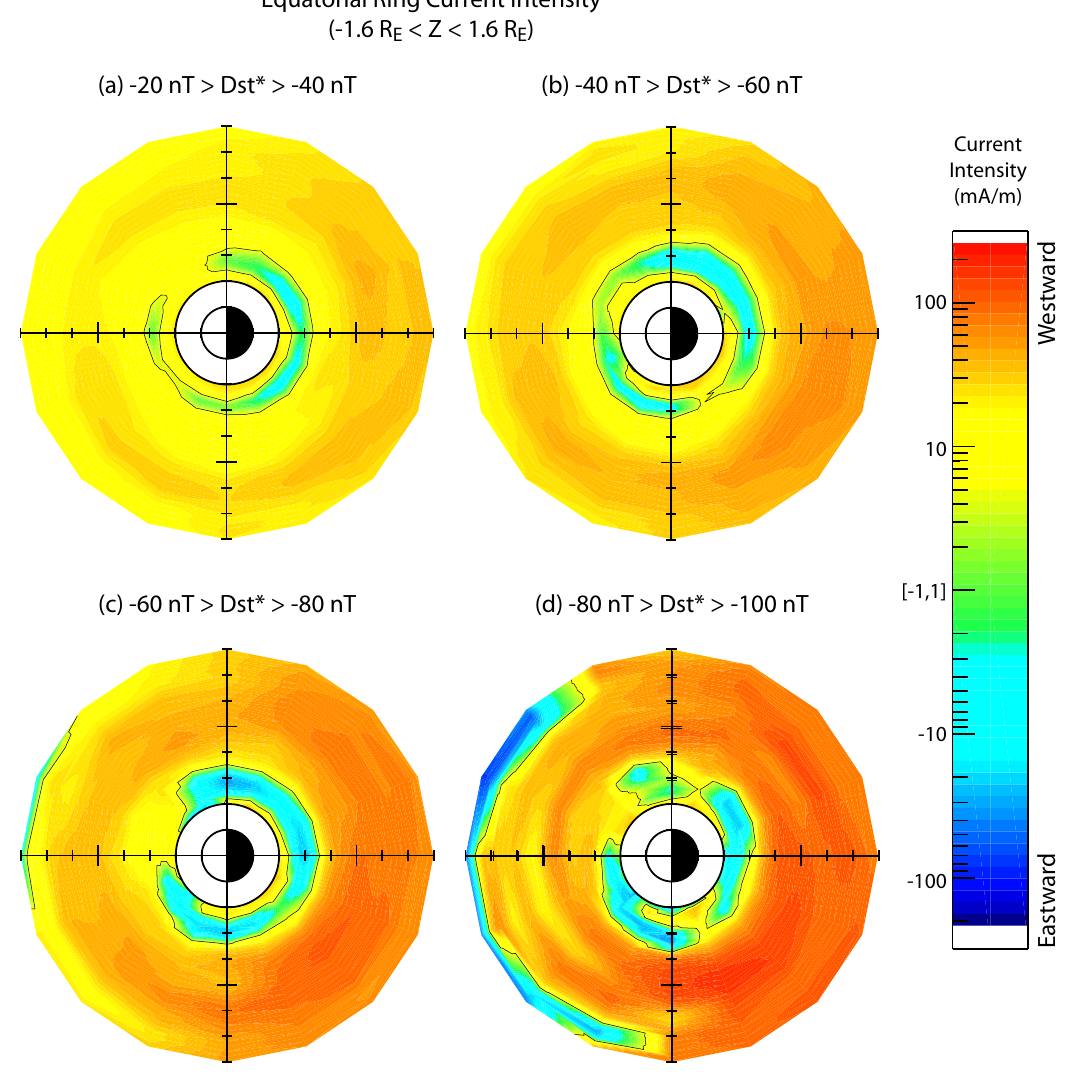
Fig. 8. Equatorial ring current intensity as a function of magnetic local time and distance from the dipole axis for each of the four D st * levels. A logarithmic scale for the color bar has been chosen and is kept constant for each